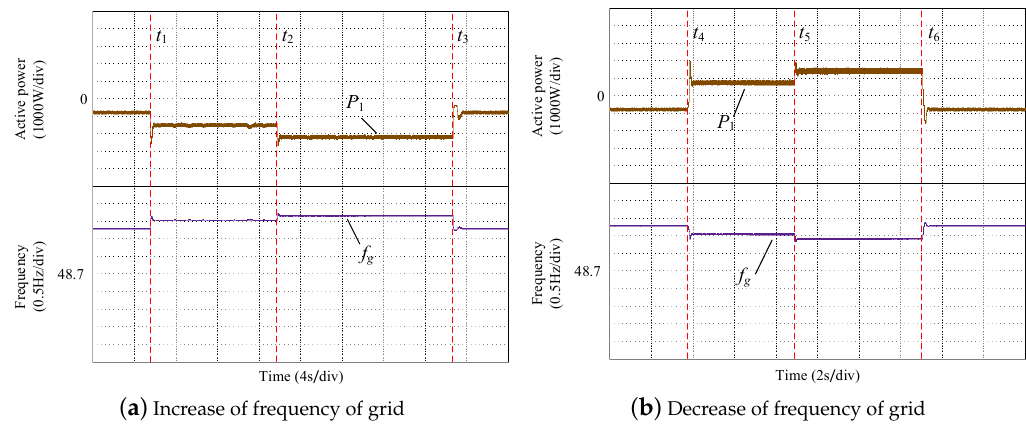
( b ) Decrease of frequency of grid Figure 8. Waveforms of power and frequency of grid-connected